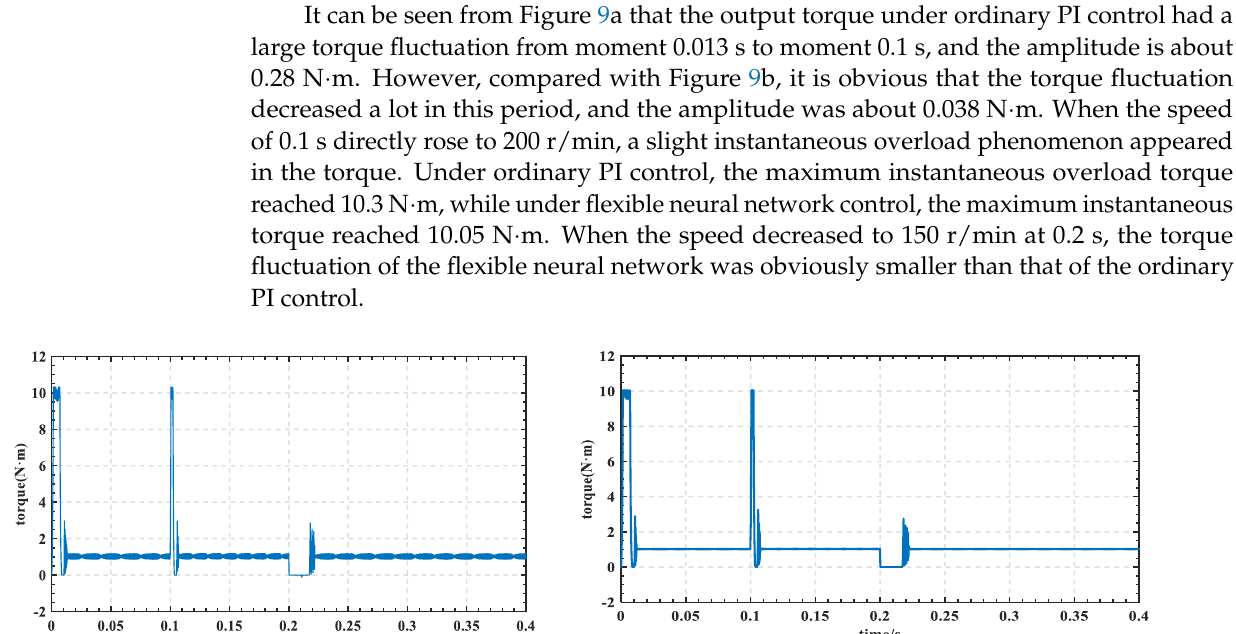
Figure 8. Comparison of current: ( a ) PID control system current and ( b ) FNN control system current.